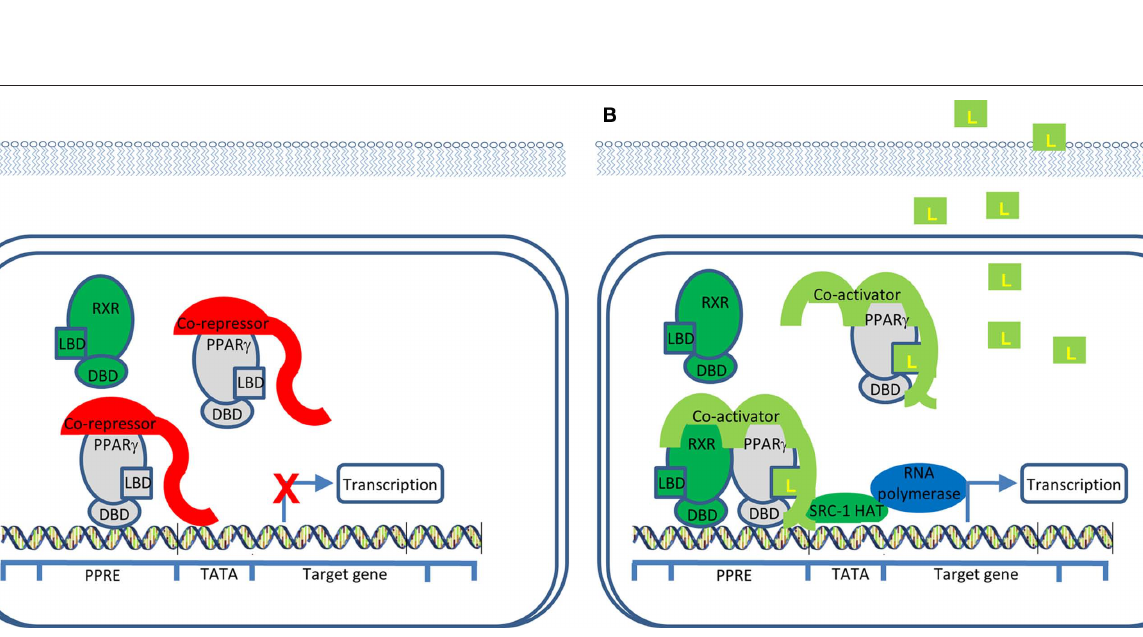
dimerization with retinoid receptors. These multimeric complex activates transcriptional activity and gene expression. L, ligand; RXR, retinoid receptor; LBD, ligand binding domain; DBD, DNA binding domain; PPRE, PPAR responsive element; SRC-1, steroid receptor co-activator-1; HAT, histone